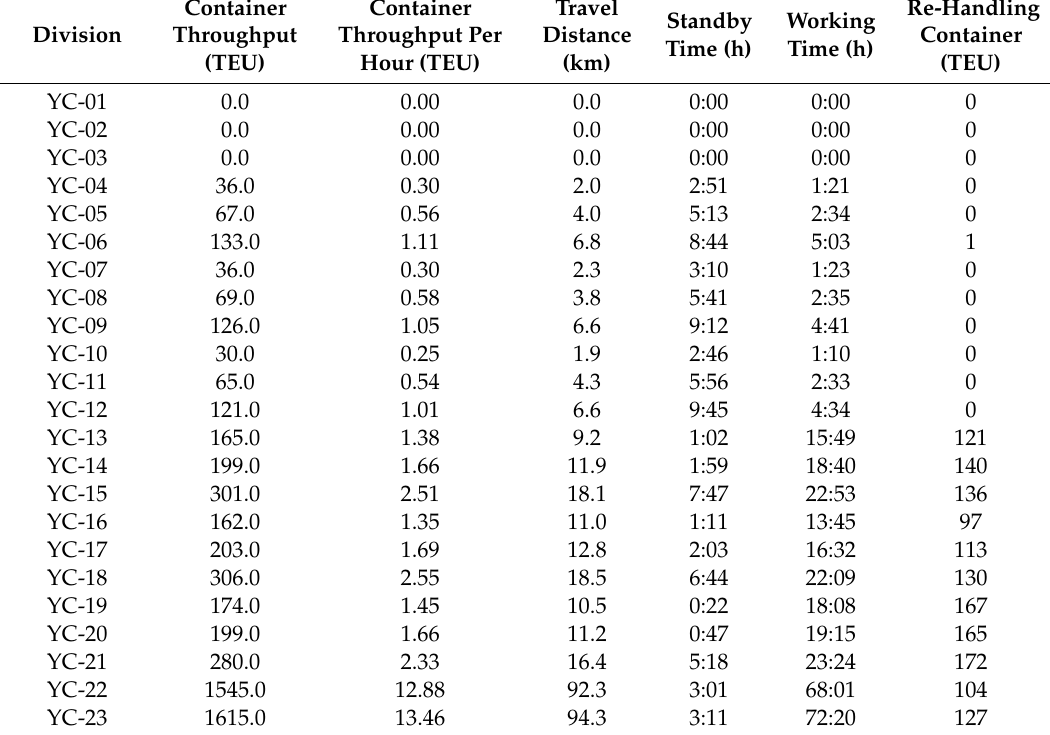
Table A1. Simulation results for the virtualized port-container terminal (yard